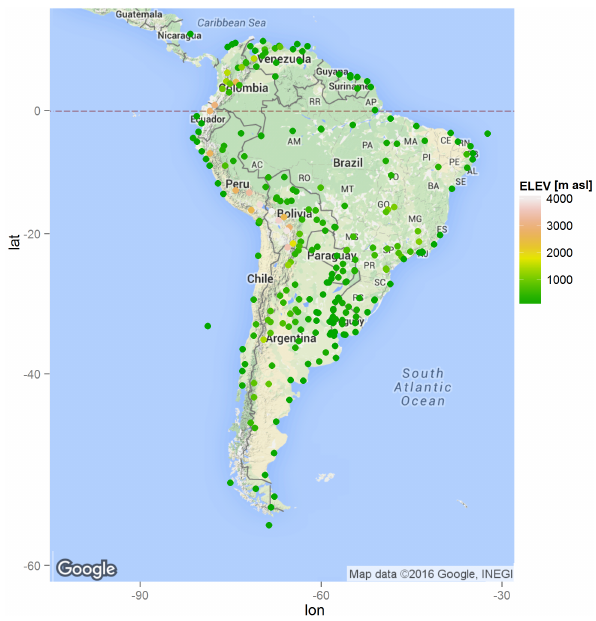
Figure 1. Spatial distribution of temperature gauges used in this study. The colour of the GSOD stations refers to the elevation, ex- pressed in